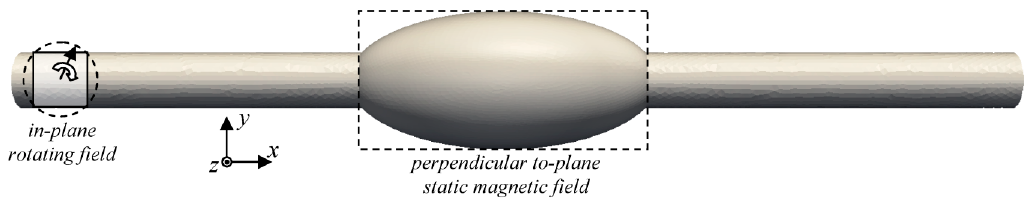
Figure 2. Magnetic nanofiber with bead, simulated using a static and a rotating magnetic field. The fiber diameter is 200 nm, the length 3600 nm, the cross ‐ section diameter of the bead is 560 nm and the bead length 1120 nm.